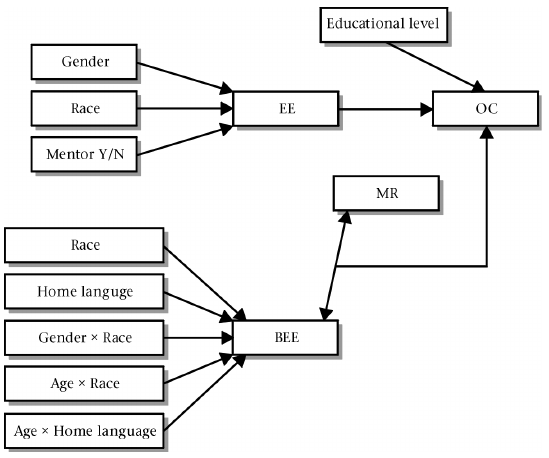
Figure 15: An Integrated predictive model of organisation